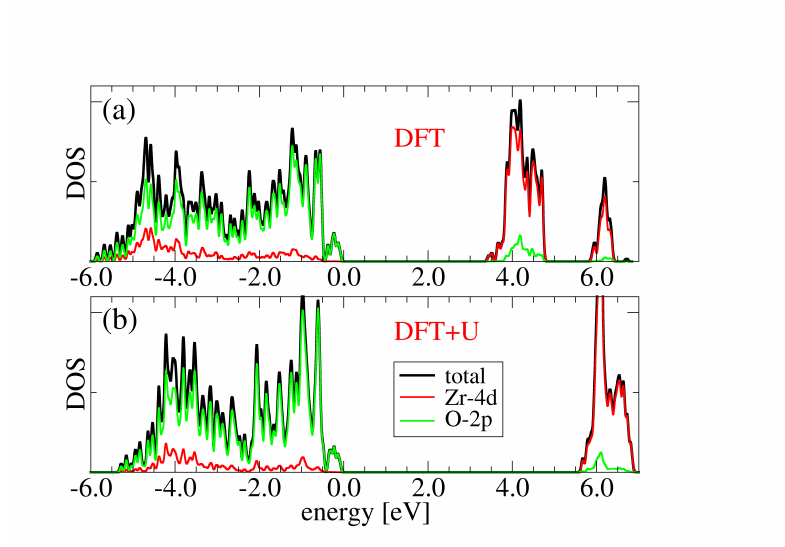
Figure 1. ( a ) The density of states (DOS) of c-ZrO 2 calculated at the PBE level of theory; ( b ) DOS of the same system, calculated with U (Zr-4d) = 2.85 eV and U (O-2p) = 9.16 eV. See text for a discussion of these values which have been calculated by linear response. The Fermi energy is set to zero in both